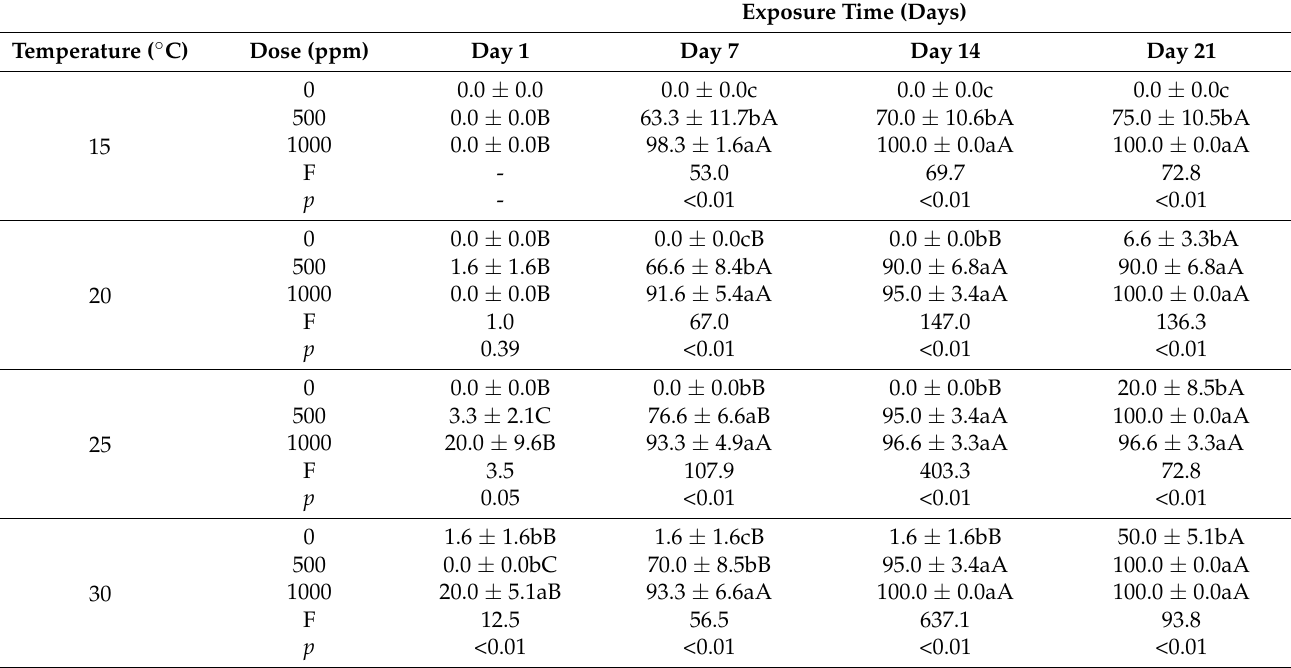
Table 2. Mean mortality (% ± SE) of C. ferrugineus adults exposed for 1, 7, 14, and 21 days to wheat treated with three different doses of diatomaceous earth (0, 500, and 1000 ppm) and four different temperatures (15, 20, 25, and 30 ◦ C), at 55%